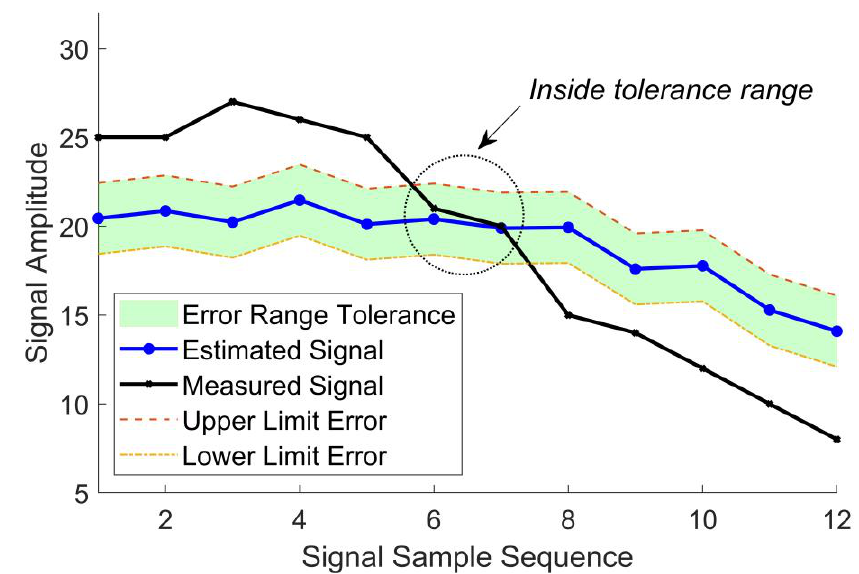
Figure 3. Error thresholds and alarm conditions.